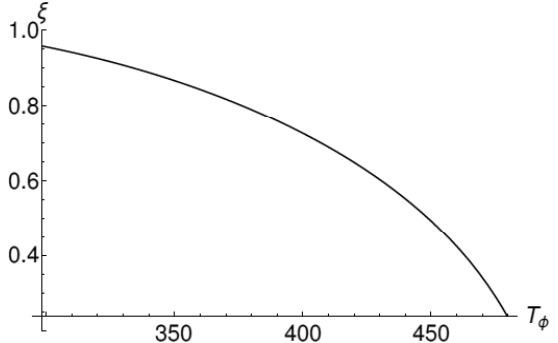
Fig. 7. Molar fraction  transformed in vapor in the transition c  as a function of temperature T